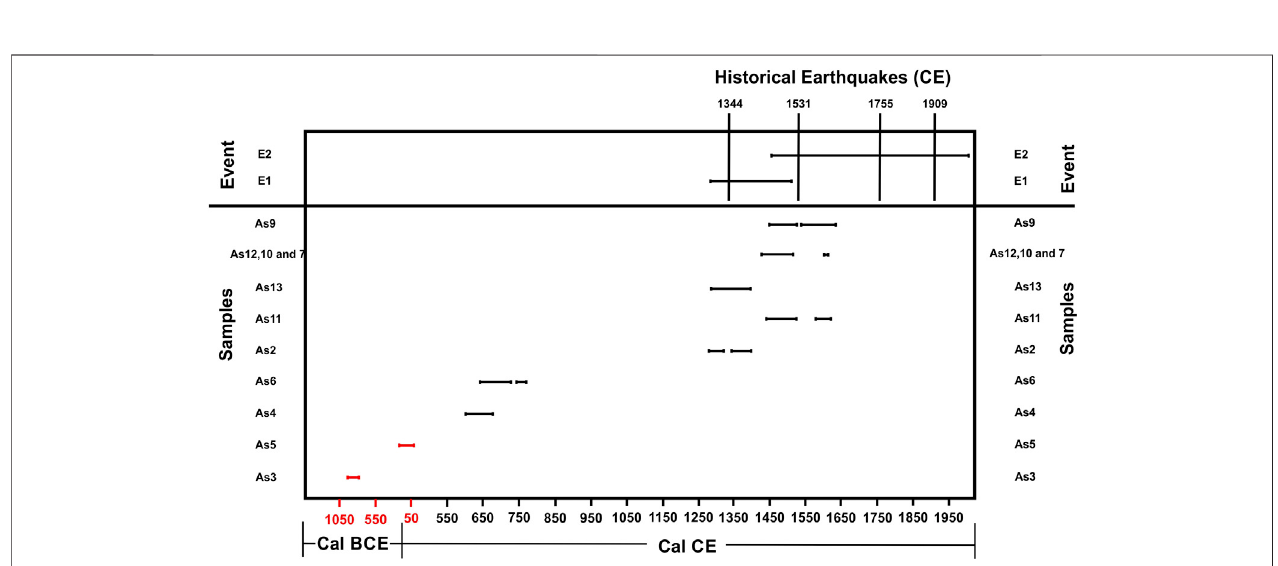
FIGURE 8| Scheme representing the relationship between the C14 calibrated ages for Alviela trench SW-wall samples and thehistorical earthquakes reported for the LTV.